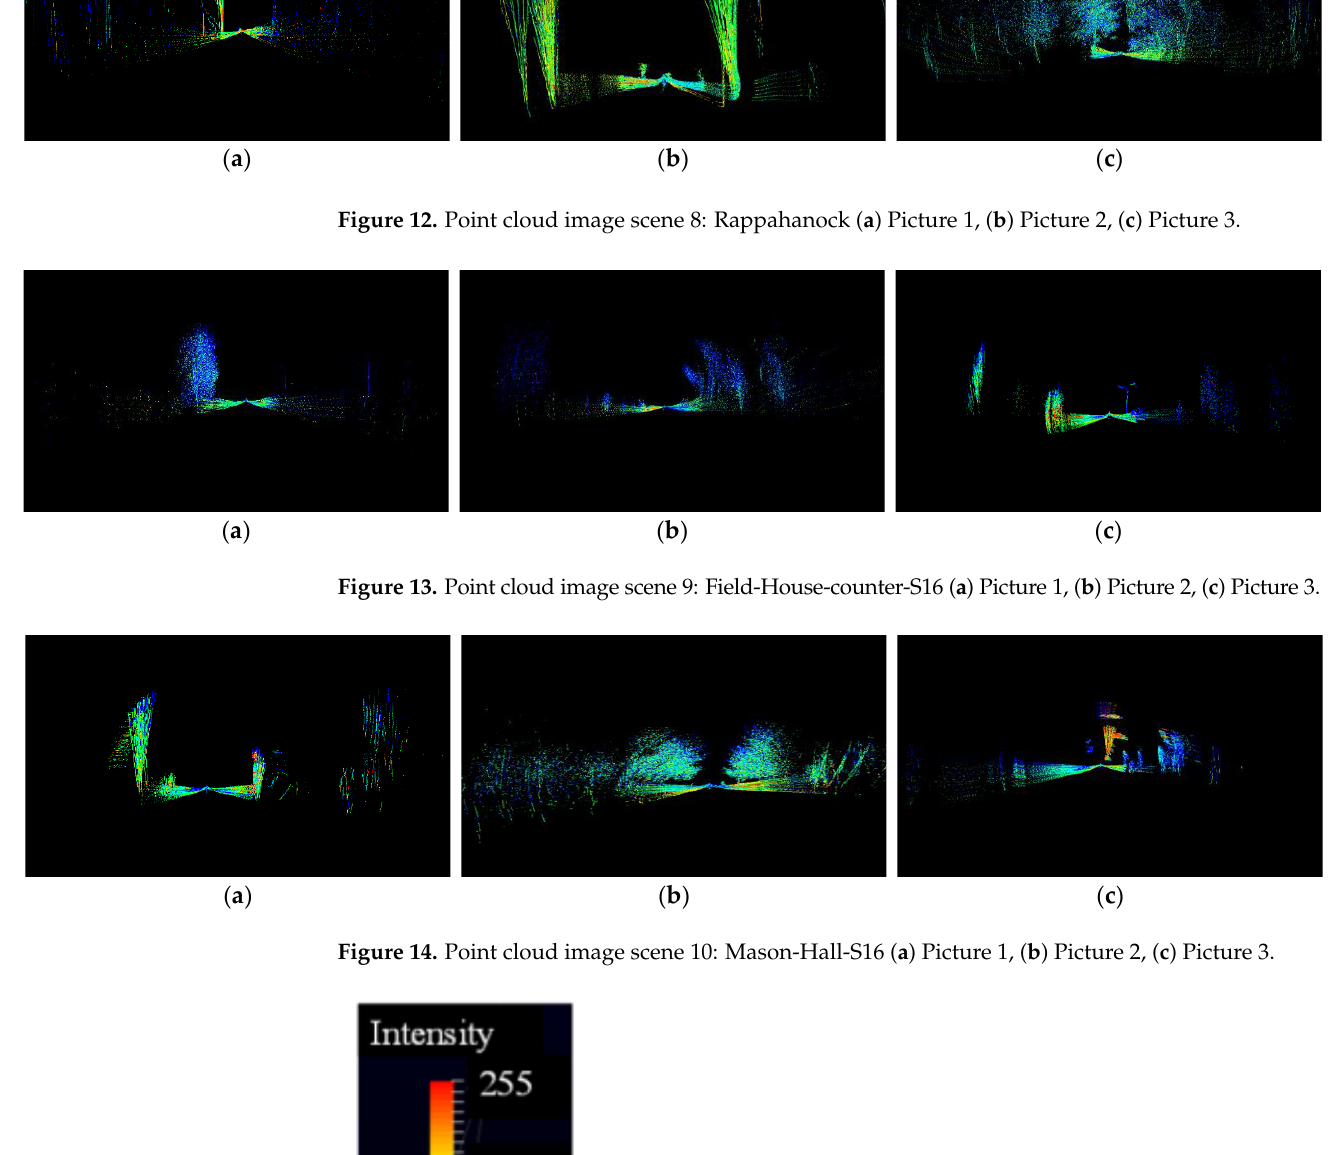
Figure 13. Point cloud image scene 9: Field-House-counter-S16 ( a ) Picture 1, ( b ) Picture 2, ( c ) Picture